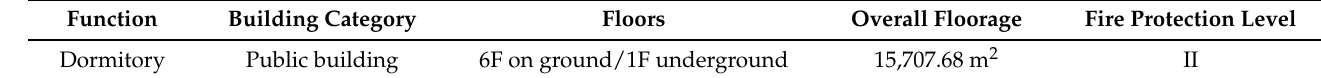
Table 3. Features of the Case Building.